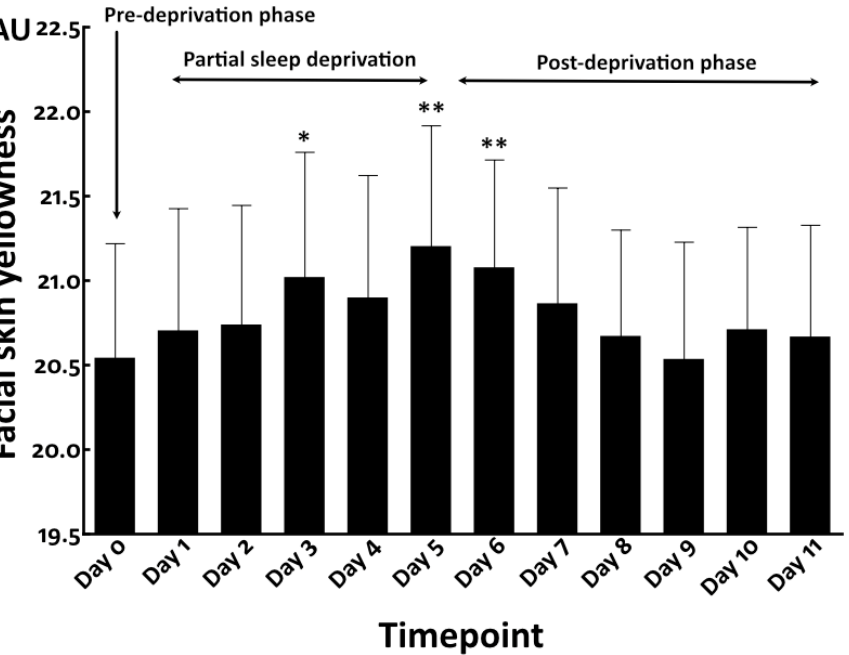
Figure 7. Facial skin yellowness in repeated partial sleep deprivation study. *: p < 0.05 compared to Day 0. **: p < 0.01 compared to Day 0.